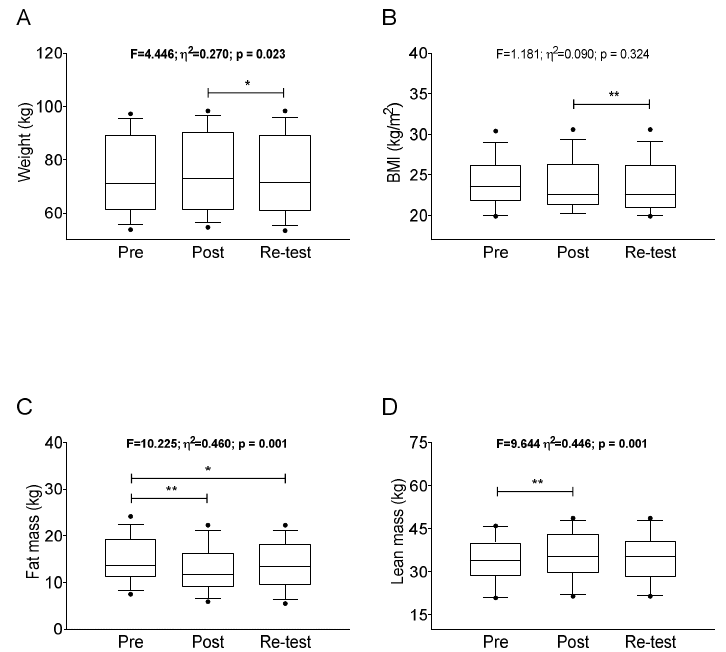
Figure 2. Changes in anthropometry (i.e., weight ( A ) and BMI ( B )) and body composition (i.e., fat ( C ) and lean mass ( D )) after the bicycle touring intervention. p value derived from repeated-measures analysis of variance. Data are shown as mean ± 95% confident intervals. * p < 0.05; ** p < 0.01.